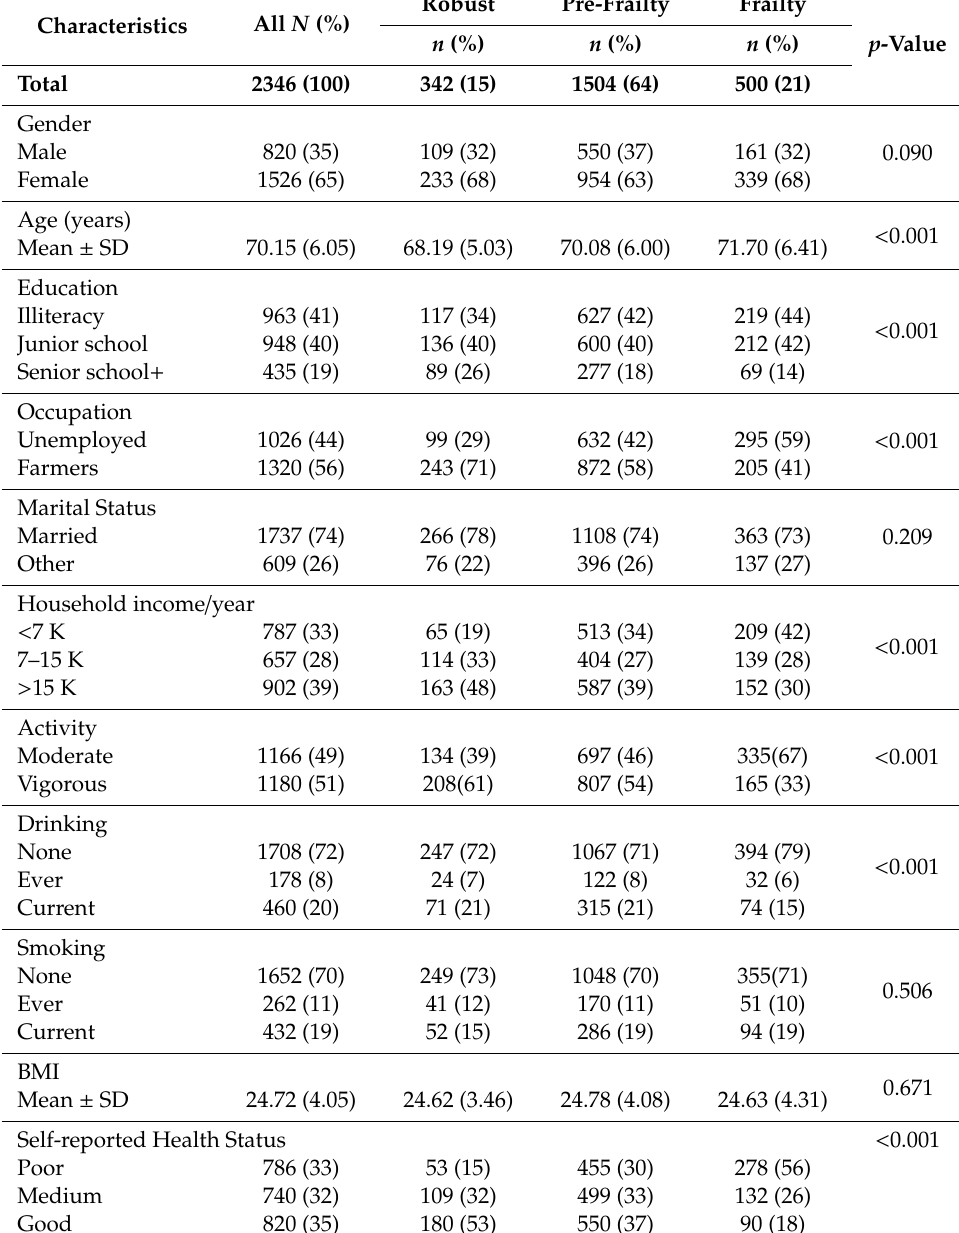
Table 1. Demographic characteristics of older people by category of frailty status in rural Shandong, China ( n = 2346).